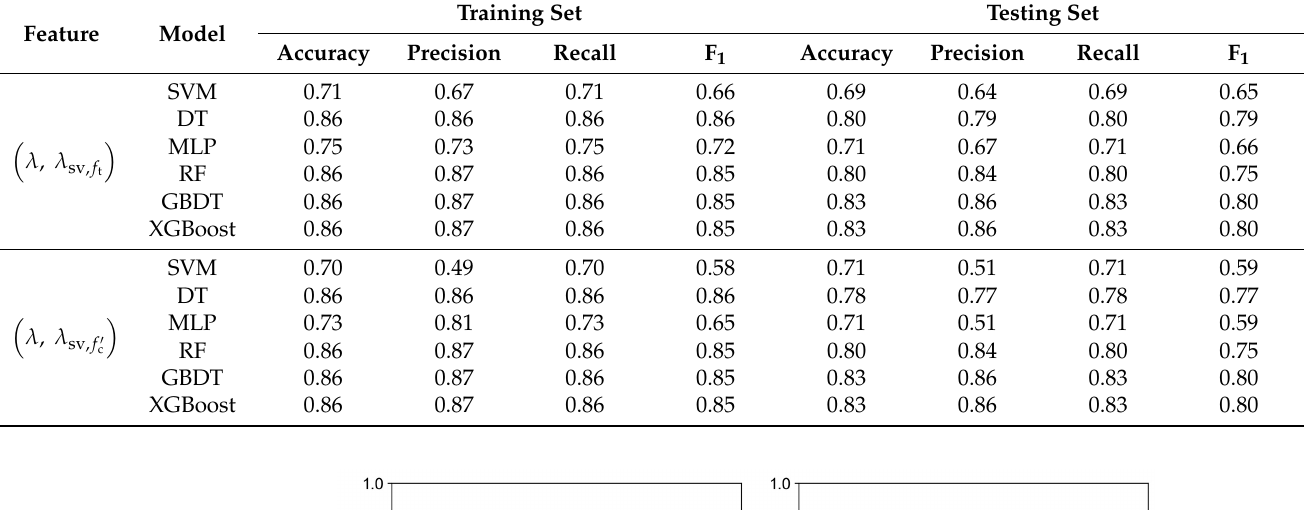
Table 2. The prediction performance of six developed machine-learning models in predicting failure modes of RC beams.